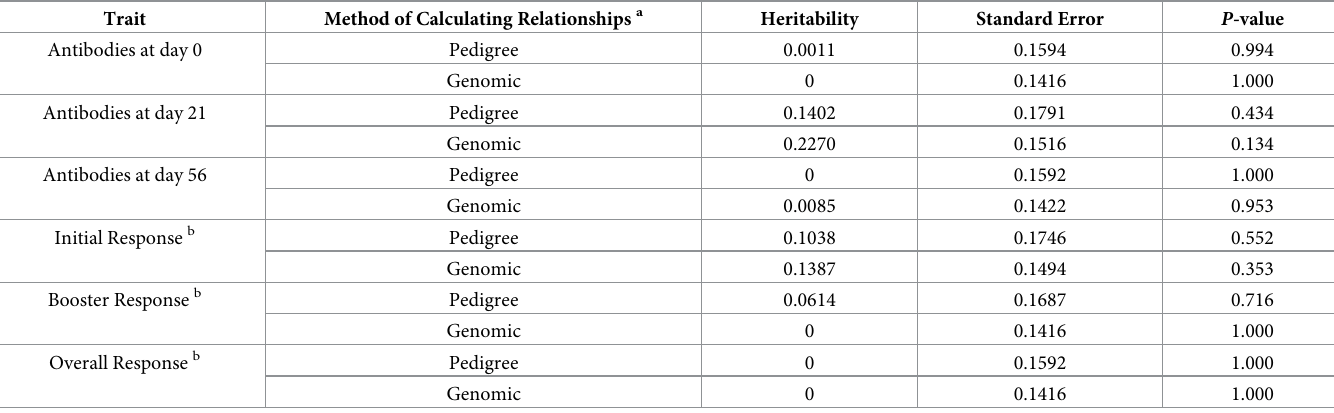
Table 2. Heritability estimates for humoral response to E . coli O157:H7 Siderophore and Receptor Porin (SRP) protein vaccination in calves ( n = 651). Trait